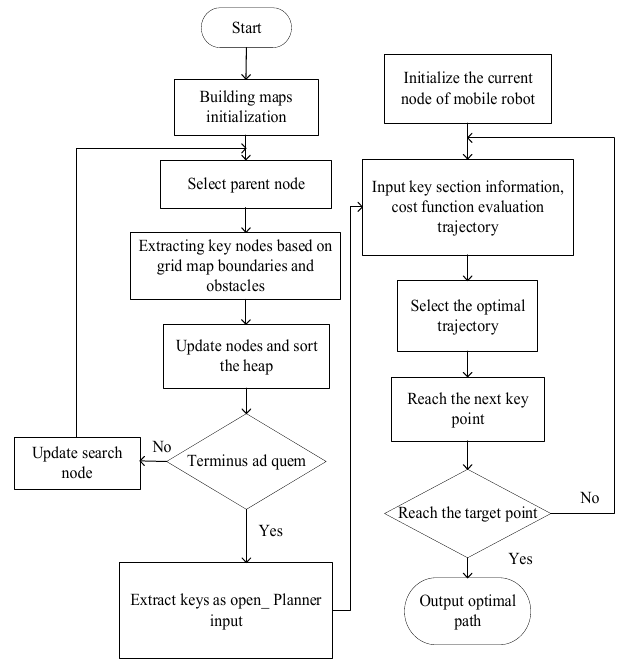
Figure 6. Flow chart of fusion algorithm.